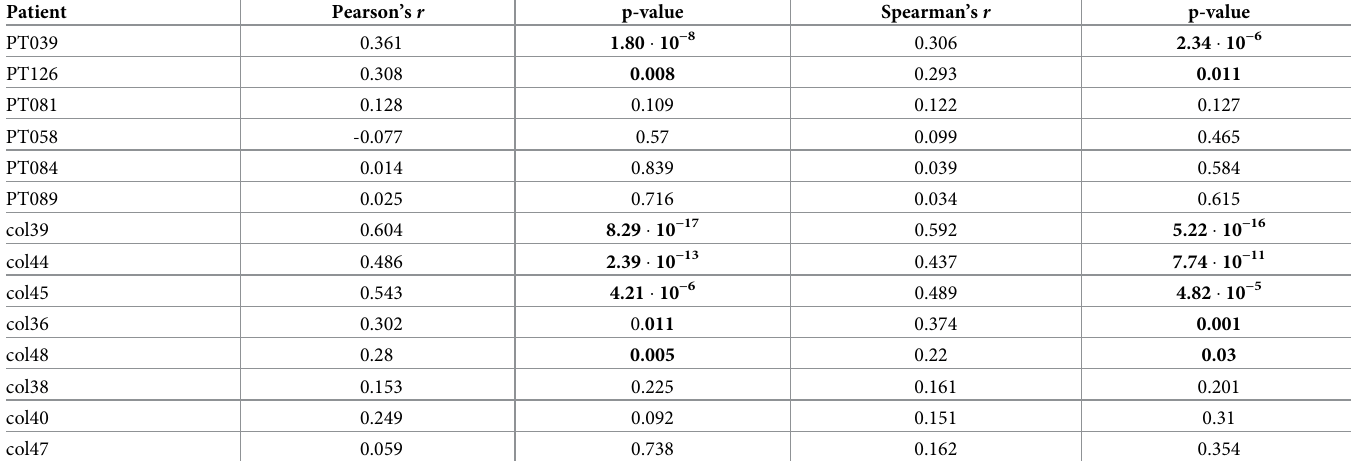
Table 1. Table showing the correlation coefficients and statistical significance for relationships between inferred CNV and putative driver alteration counts for cells belonging to each patient. p-values less than 0.05 are shown in bold.